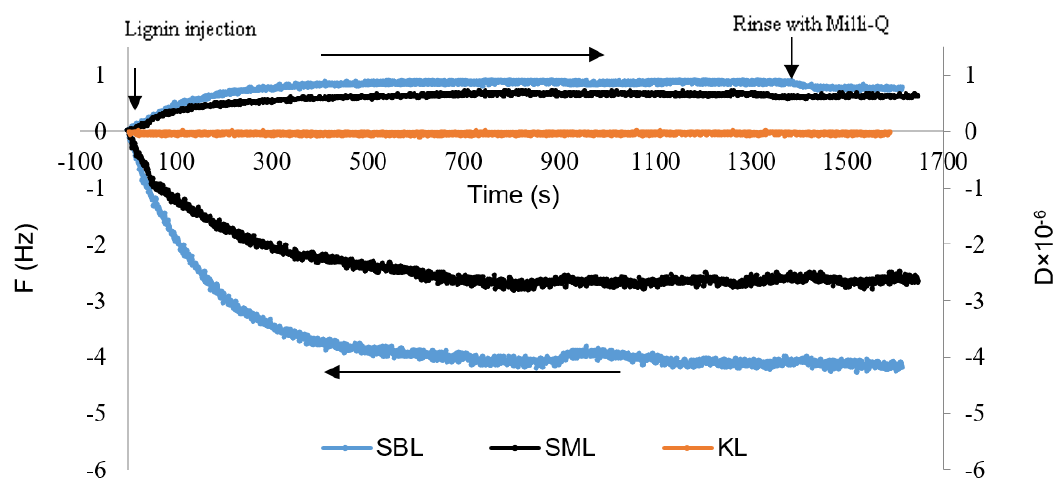
Figure 5. Adsorption of lignin derivatives (500 mg/L concentration) on Al 2 O 3 coated Quartz sensors at pH 7.8. pH